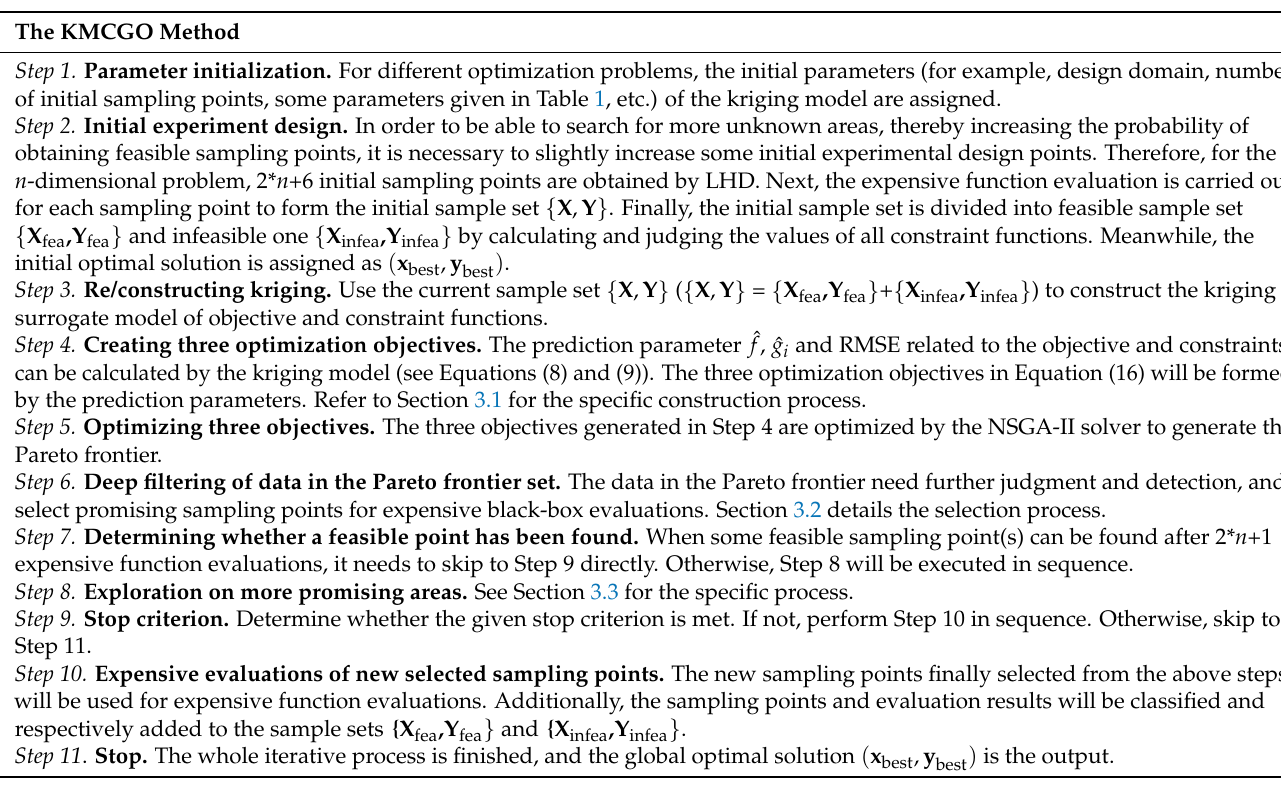
Figure 1. Flowchart of the kriging-assisted multi-objective constrained global optimization (KMCGO) method. Table 2. The specific realization of the KMCGO